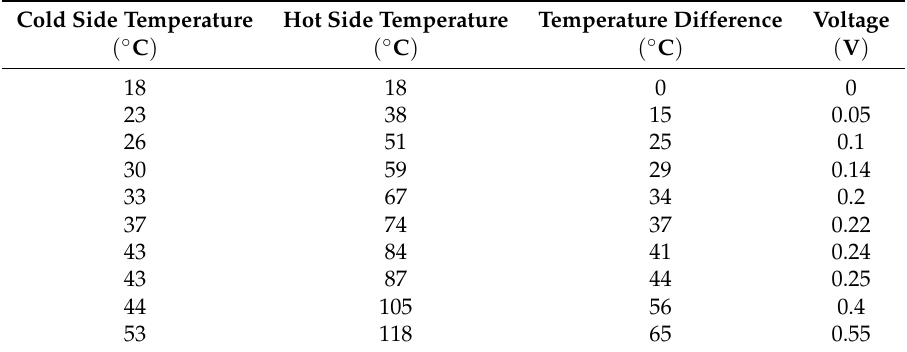
Dependence of the voltage on temperature difference in Peltier cells for the first experimental